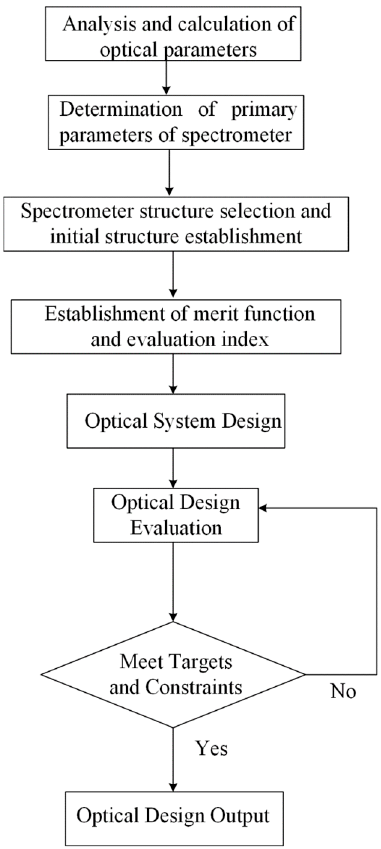
Figure 8. Flowchart of the design process in engineering. Table 2. Specification requirements of the spectrometer.